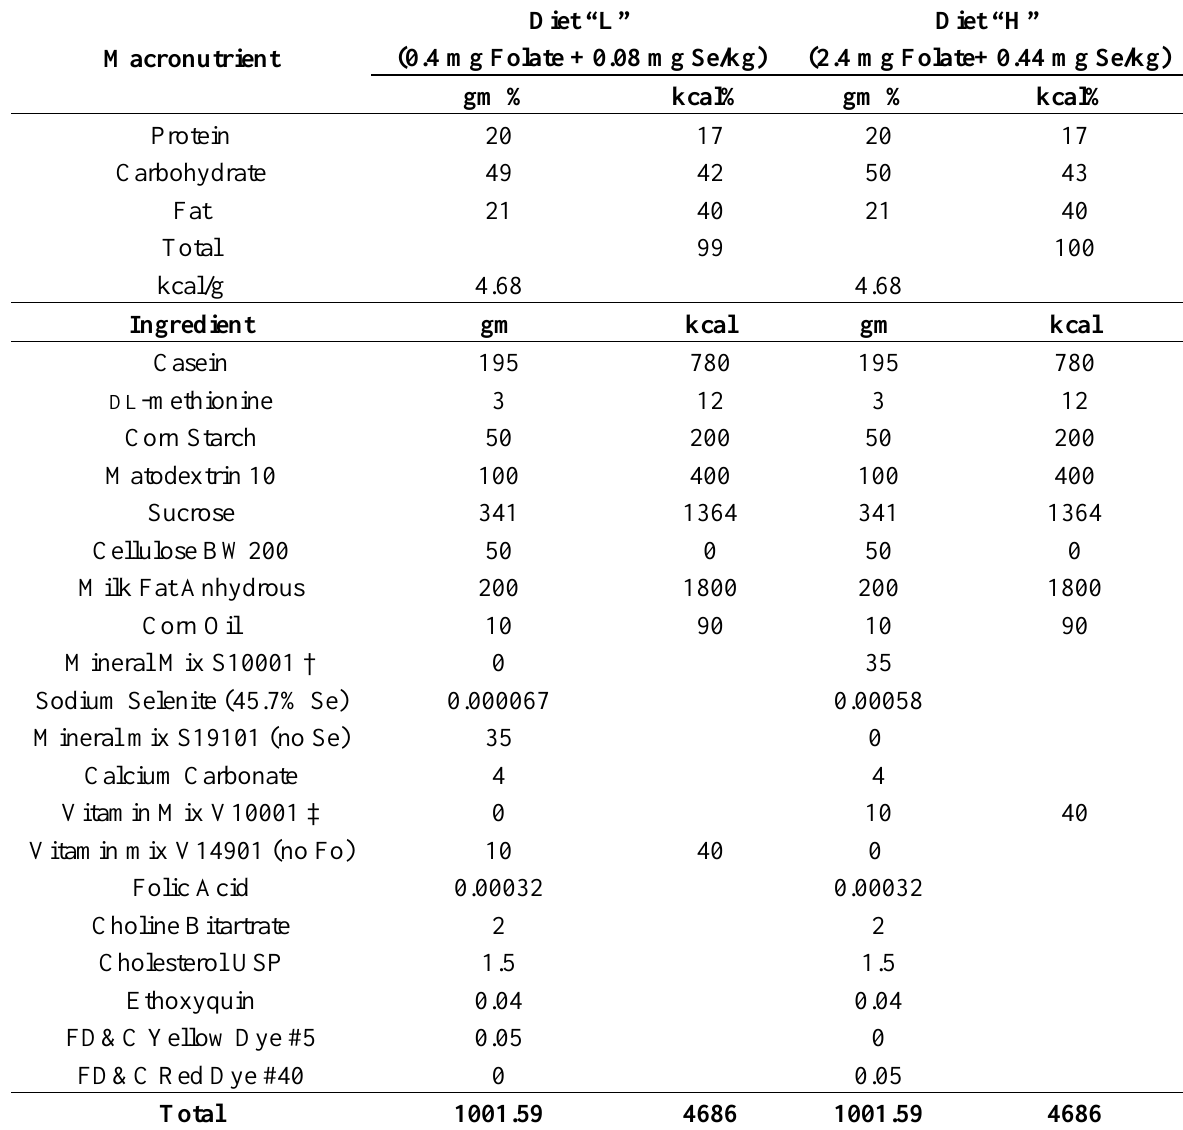
Table 1. Composition of experimental diets (as